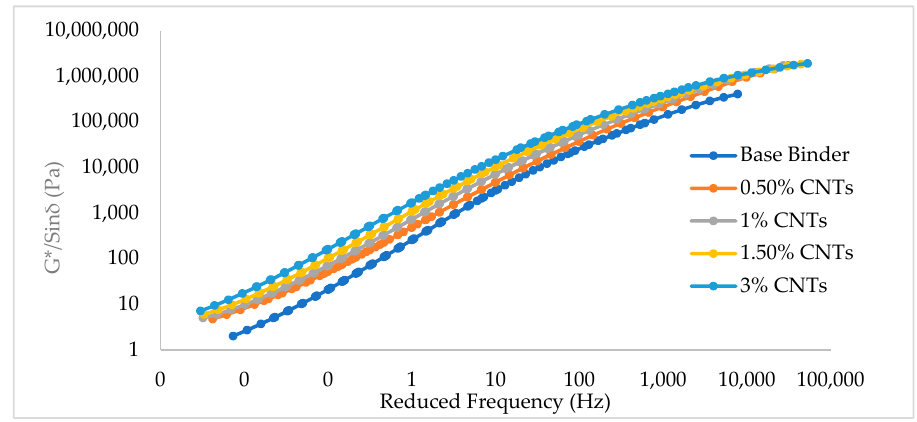
Figure 14. Master curve of G*/Sin δ for CNT-modified and unmodified bitumen at 58 °C.